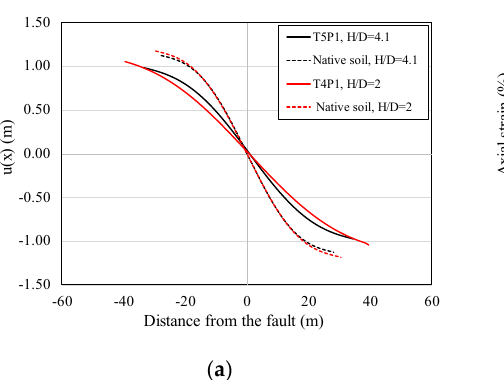
Figure 6. Comparison between the developed analytical model for the trenched pipeline and the analytical model for uniform seabed soil, T4P1 and T5P1 ( β = 0°): ( a ) deformed pipeline shape, ( b ) distribution of axial strains along the pipeline.